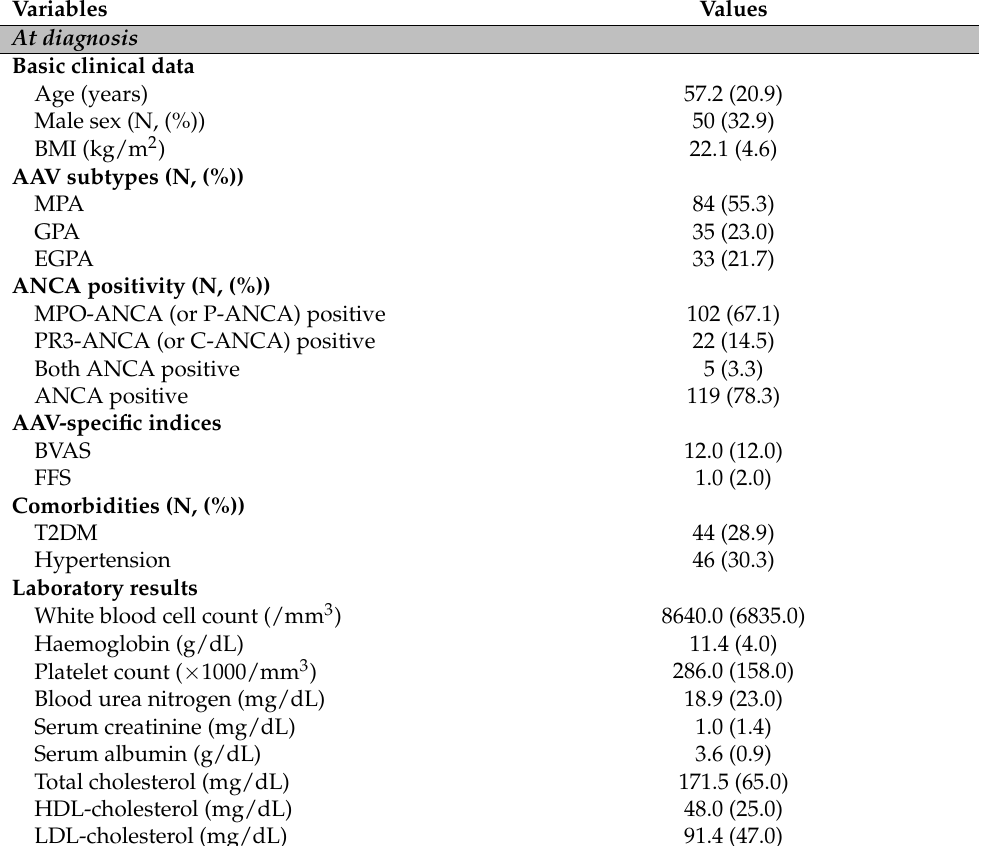
Table 1. Characteristics of AAV patients (N =